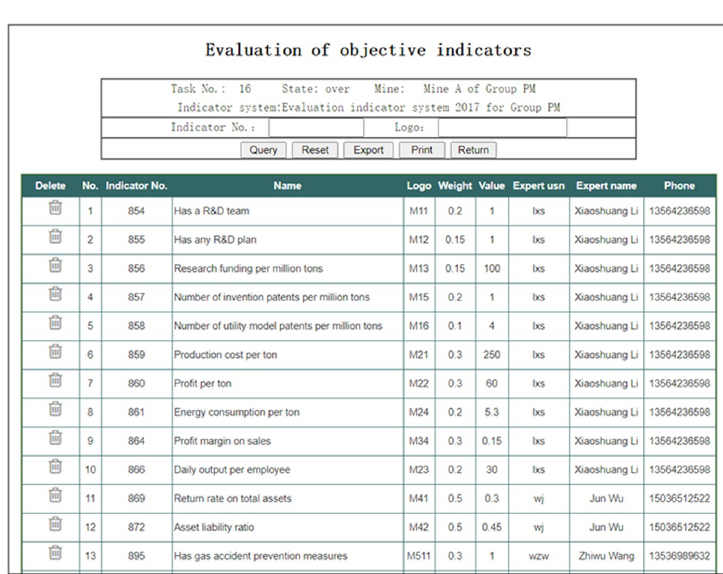
Fig 15. Evaluation data of final-level objective